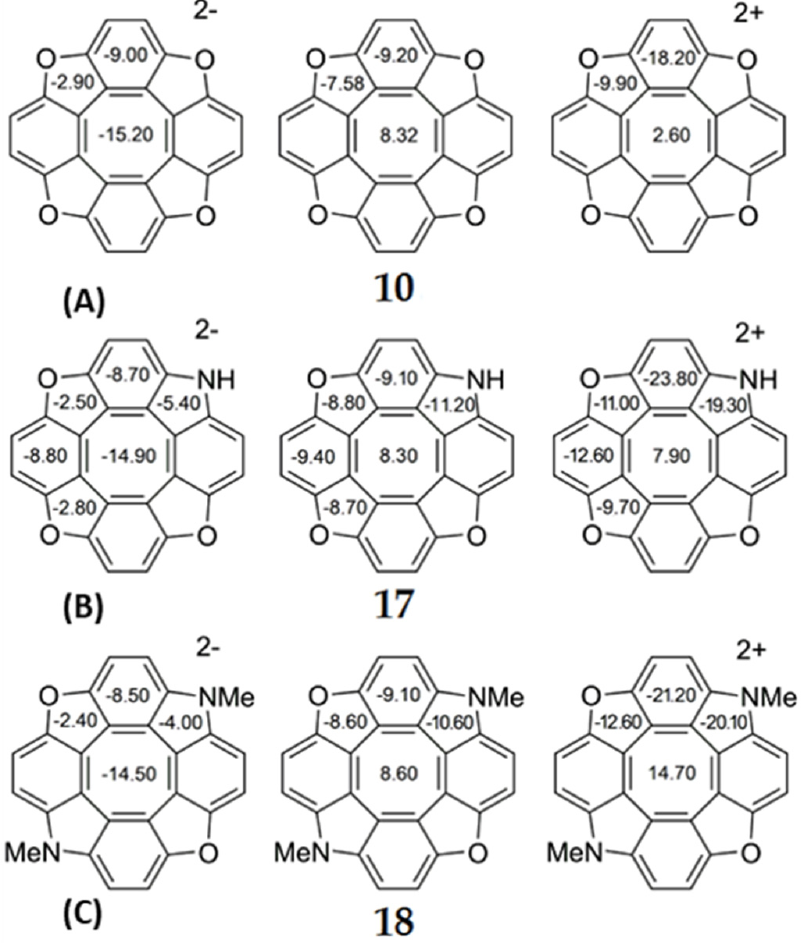
Figure 8. The values of NICS(0) indices for neutral and doubly ionized tetraoxa[8]circulene ( A ), azaoxa[8]circulene ( B ) and N , N -dimethyldiazadioxa[8]circulene ( C )